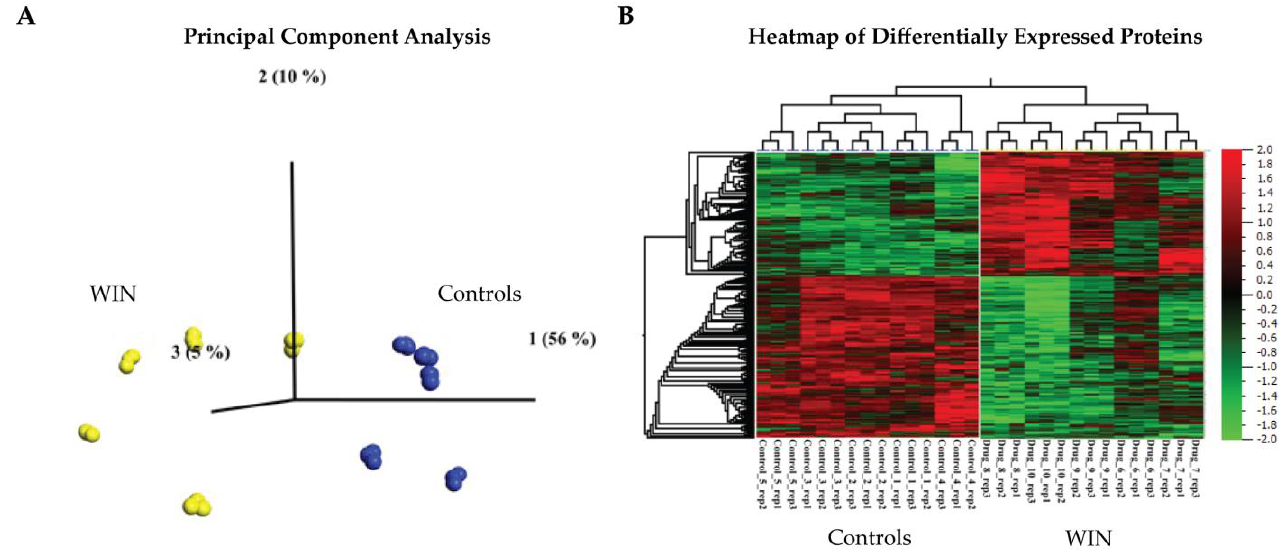
Figure 1. Synaptoproteomic analysis of the adolescent PFC following WIN-treatment. Male rats were exposed to a synthetic cannabinoid (WIN) or vehicle (i.e., controls) in mid-adolescence/puberty (PND 42-52) and proteomic analyses were applied to synaptosomal extracts from the prefrontal cortex (PFC) in late adolescence (PND 64) on the drug abstinence day (AD) 12 (N = 5 animals per condition and N = 3 technical replicates per animal in the proteomic analysis). ( A ) Supervised principal component analysis (PCA) following one-way Analysis of Variance (ANOVA) shows that 71% of the data are explained in PC1-3 for N = 487 differentially expressed proteins at q < 0.01. ( B ) Synaptoproteomics-derived heatmap of hierarchical cluster analysis of the N = 487 differentially expressed proteins in the PFC of WIN-treated animals versus controls (ANOVA, q < 0.01). The complete list of differentially expressed proteins is presented in Supplementary Dataset S2 and the Gene Ontology (GO) results are presented in Supplementary Dataset S3.